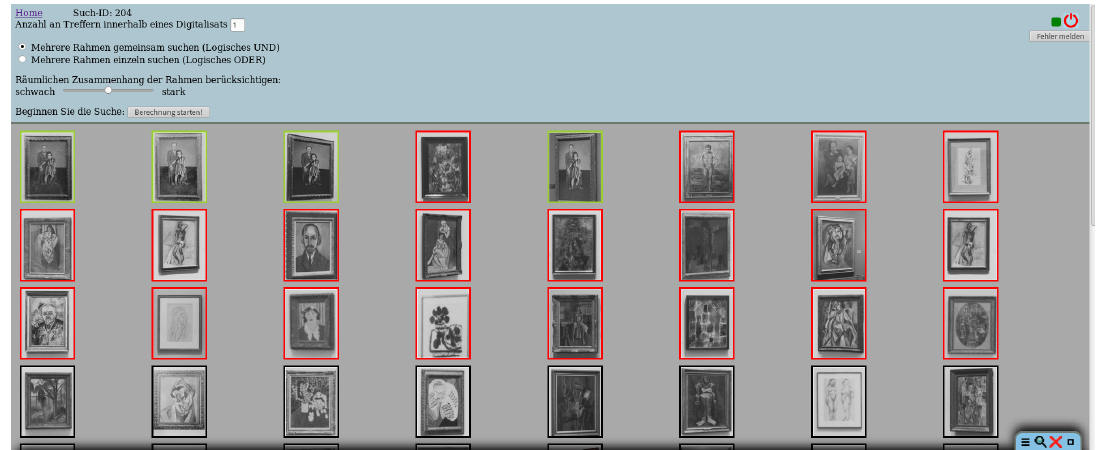
Figure 9. Search results for Balthus’ Joan Miró and His Daughter Dolores (1937, MoMA), first search process, figure shows user’s feedback, where positive detections are marked in green, negatives in red. Previously defined search constraints are visible at the top. Image rights: Computer Vision Group, Heidelberg University. Displayed photographs/details belong to the Museum of Modern Art, New